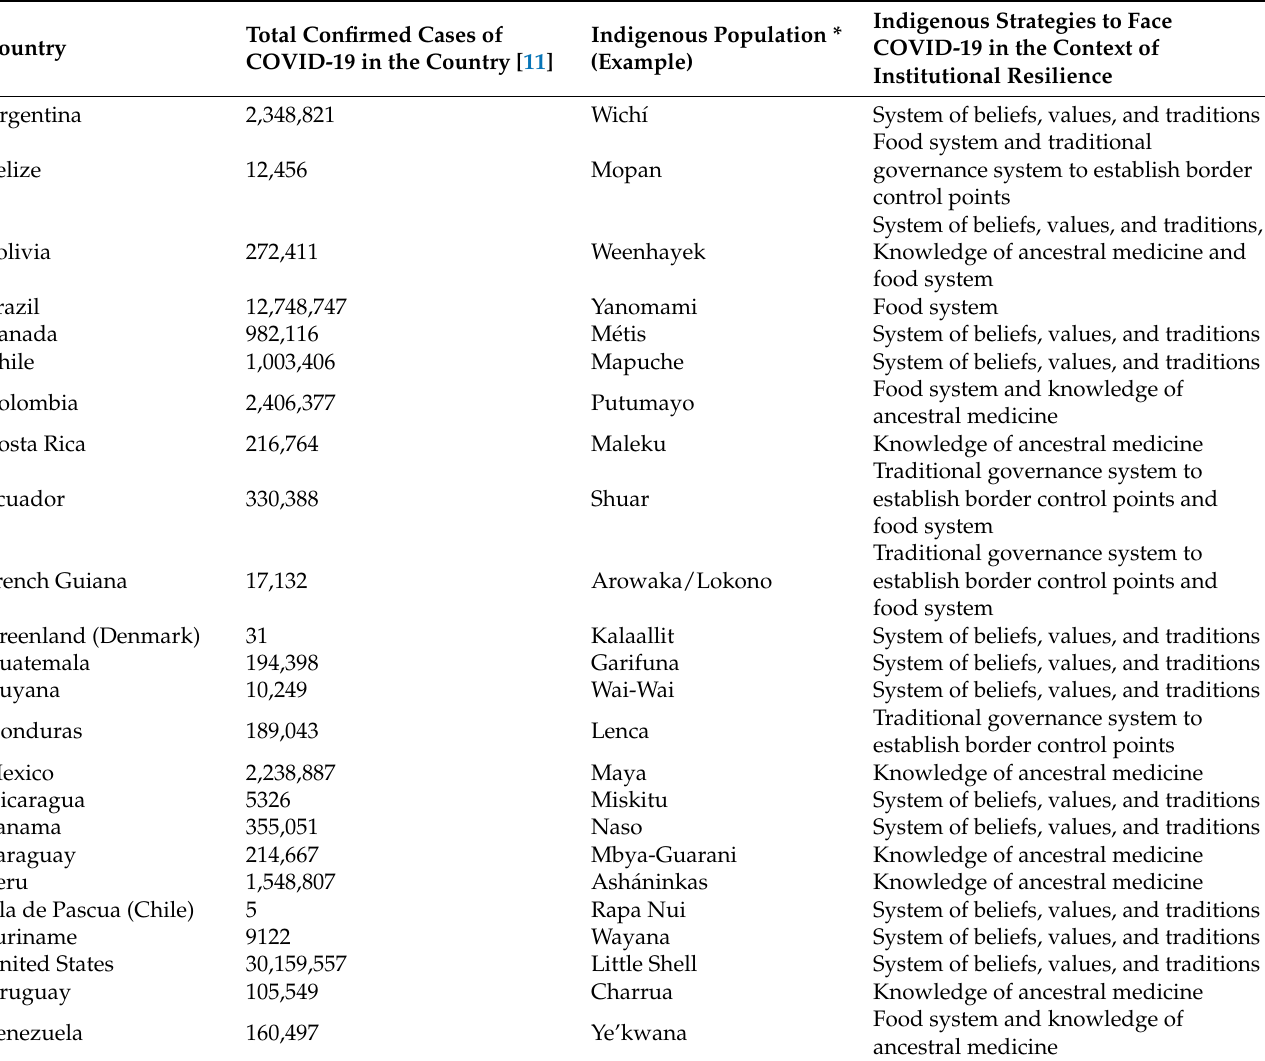
Table 5. Countries in Latin America and North America with indigenous populations and their strategies deployed in the face of